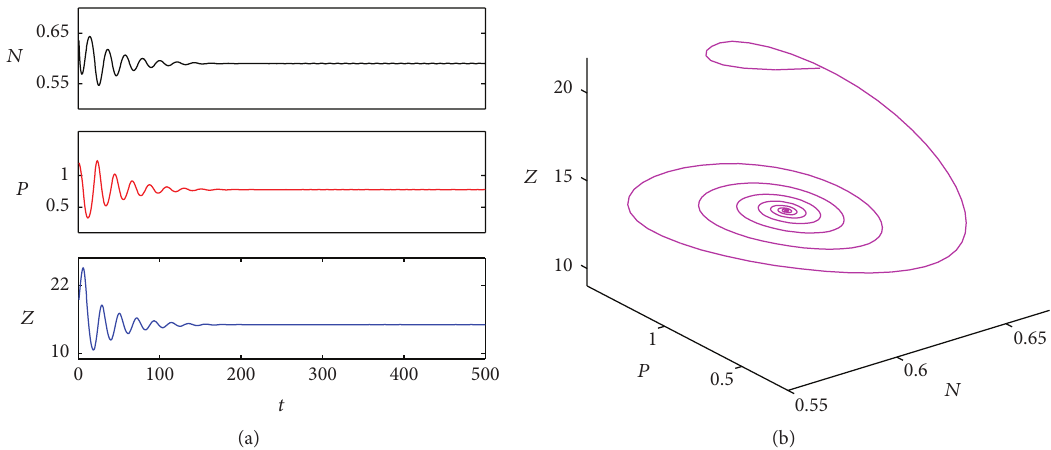
Figure 2: Numerical solutions of system (3) with 𝛼 = 0.2819 , 𝜏 = 5 , and initial point (0.7, 1.2, 18). (a) shows the time series of 𝑁 (black line), 𝑃 (red line), and 𝑍 (blue line) and (b) shows the associated phase diagram of system (3) (magenta line). The equilibrium 𝐸 ∗ is locally asymptotically stable.